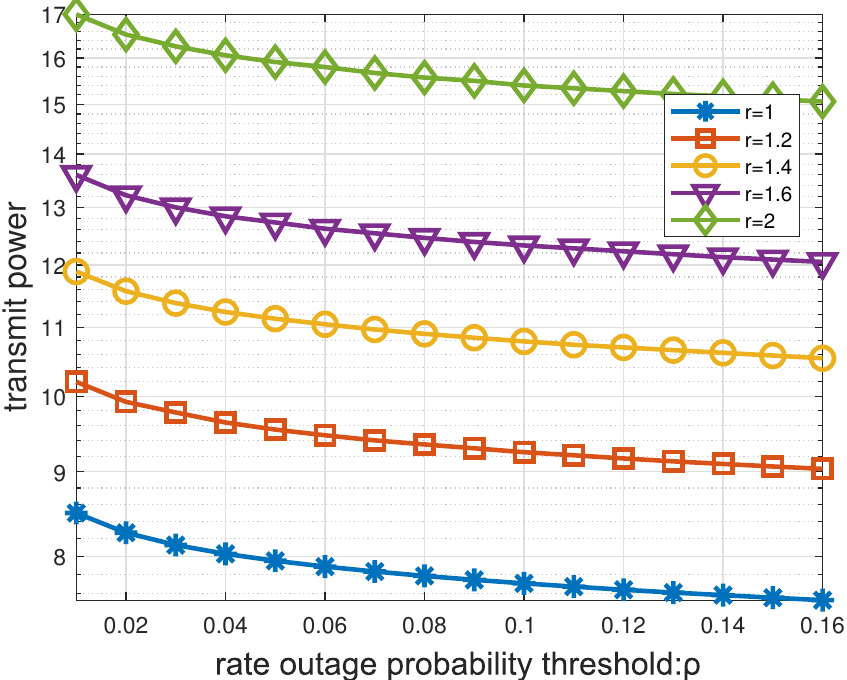
Figure 3. Transmit power versus the rate outage probability threshold ρ , when L = 2, γ = 0.02